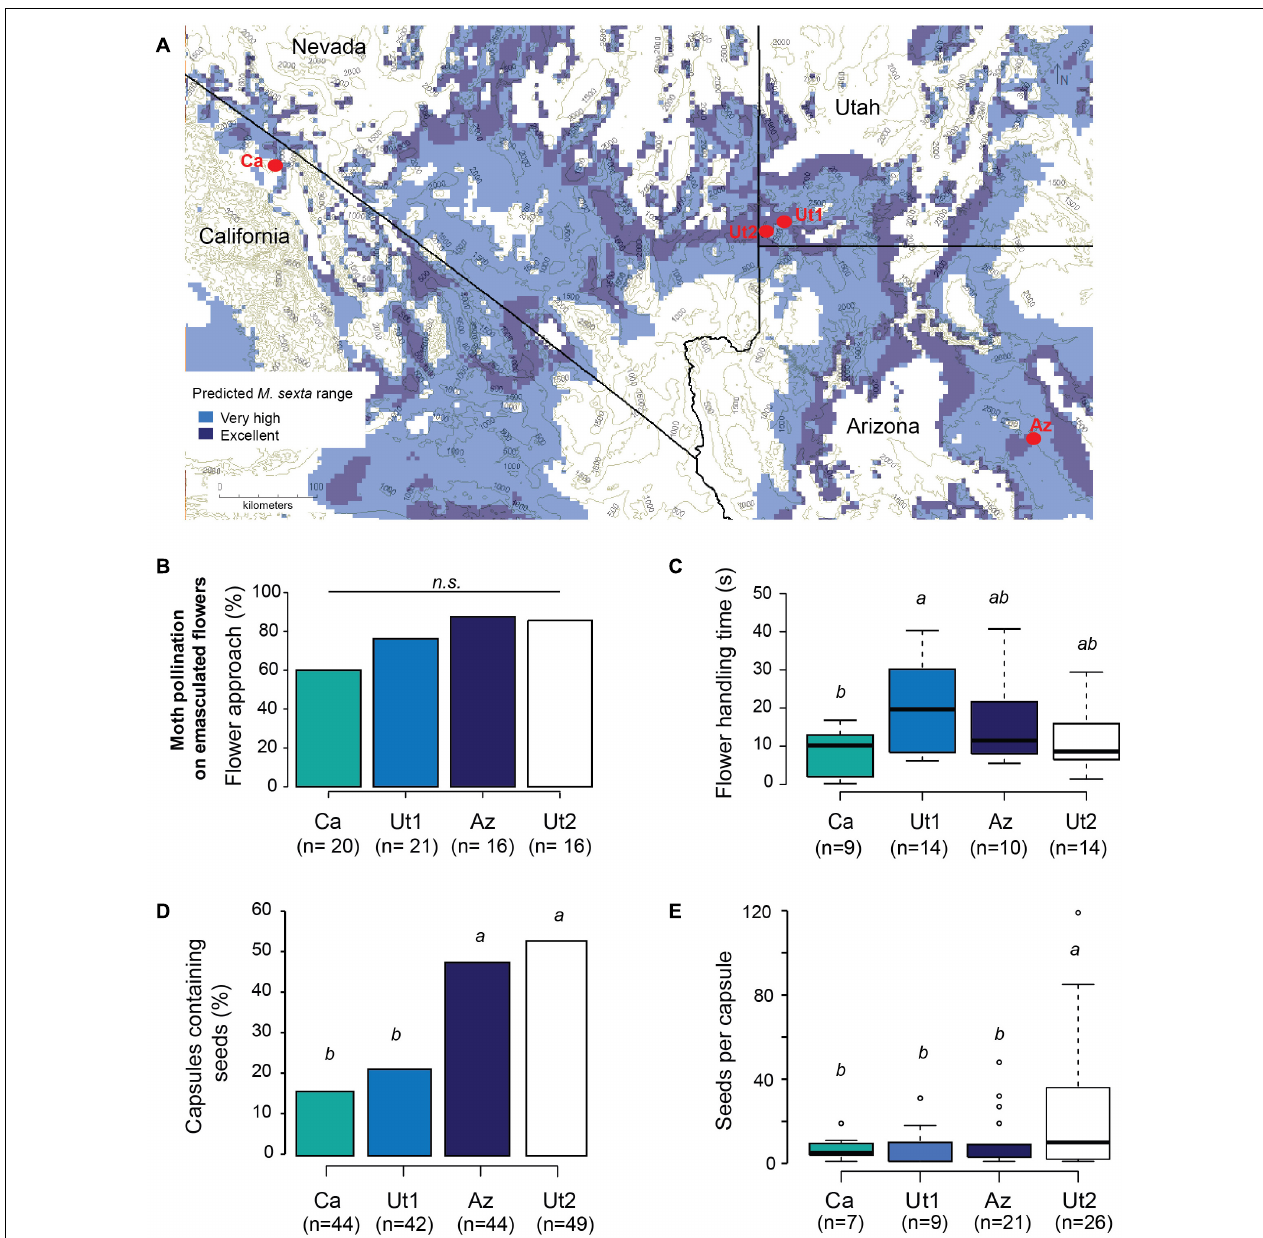
FIGURE 2 | Map of Manduca sexta predictions based on temperature range and pollination output of four natural accessions. (A) Predicted distribution map of M. sexta with temperature as the proxy parameter in the Great Basin Desert, United States. Red circles show the seed collection sites. (B) Total percentage of emasculated flowers of N. attenuata approached by M. sexta moths in a wind tunnel assay [ p = 0.1326, Holm-corrected Fisher’s exact test, data published for Ca, Az, and Ut1 (Haverkamp et al., 2019)]. (C) Flower contact time (mean ± SD) for first flower approached [ANOVA followed by Holm-corrected least significant differences, data published for Ca, Az, and Ut1 (Haverkamp et al., 2019)]. (D) Total percentage of capsules containing seeds formed after M. sexta visitation (ANOVA followed by pairwise HSD test with Holm adjustment). (E) Seed output of emasculated flowers resulting from moth pollination (generalized linear model followed by least squares pairwise comparison). Numbers below the x -axis represent replicate numbers. Different letters indicate significant differences ( p < 0.05). n.s., non-significant difference. Whiskers of the boxplots in panels (C,E) indicate 1.5 times the interquartile range; boxes depict first and third